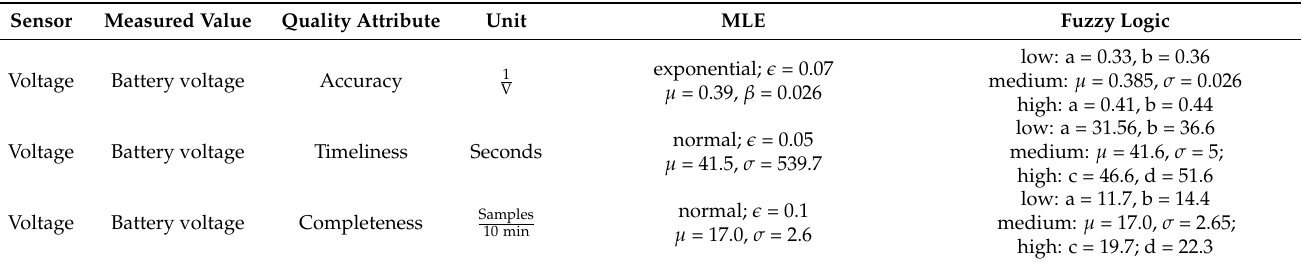
Table 5. Measurements and data quality attributes for the Intel Lab Data set. The column MLE explains the properties of the fitted distribution functions and the mean squared error (cid:101) obtained during the fit. The column fuzzy logic describes the properties of the fuzzy logic membership functions for the specified data quality